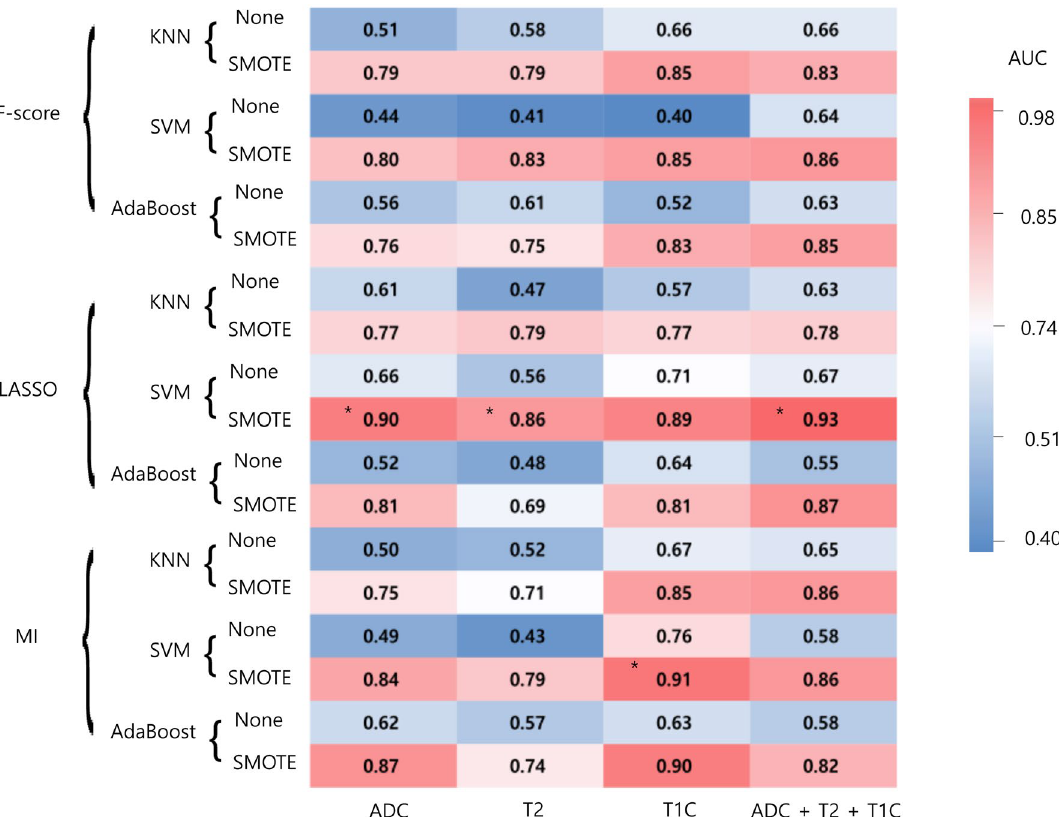
Figure 1. Heatmap depicting the diagnostic performance (AUCs) of combinations of feature selection methods, classifiers, and combination of sequences in the training set. AUC area under the curve, KNN k-nearest neighbors, MI mutual information, LASSO least absolute shrinkage and selection operator, SMOTE synthetic minority over-sampling technique, SVM support vector machine, T1C postcontrast T1WI, T2 T2WI. The best performing model in each combination of MRI sequence and mask are marked in asterisks